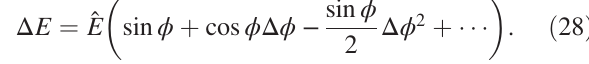
ffiffiffi p 2 . The